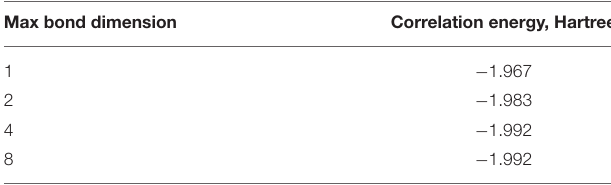
TABLE 1 | Performance of numerical evaluation of the 3:1 MERA fragment on Summit supercomputer. Number of nodes